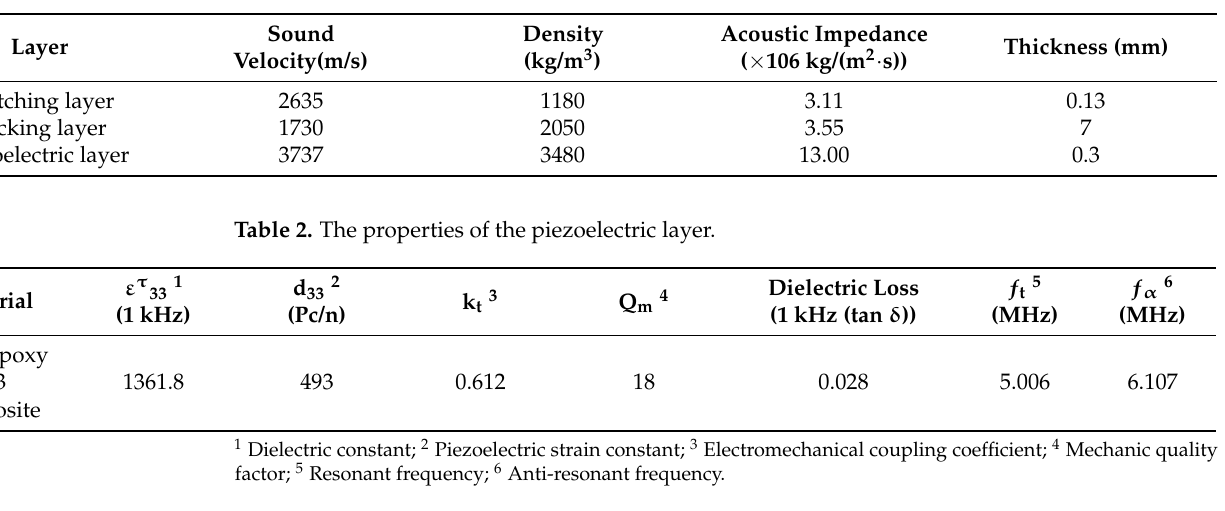
Table 2. The properties of the piezoelectric layer.